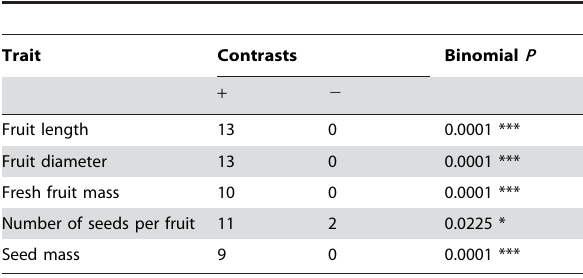
Table 3. Summary of the within-family contrasts of fruit traits between megafauna and non-megafauna species.